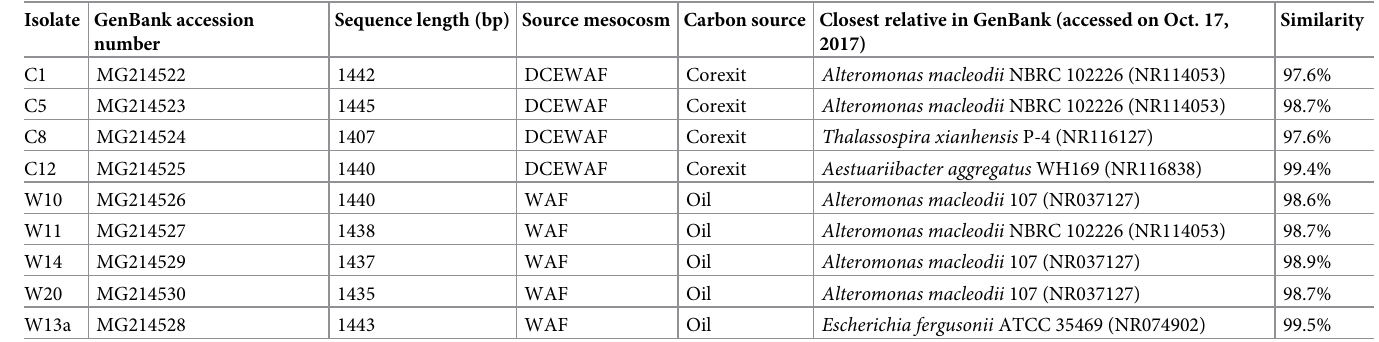
Table 1. Genotypic characterization of the nine bacterial isolates. Isolate GenBank accession